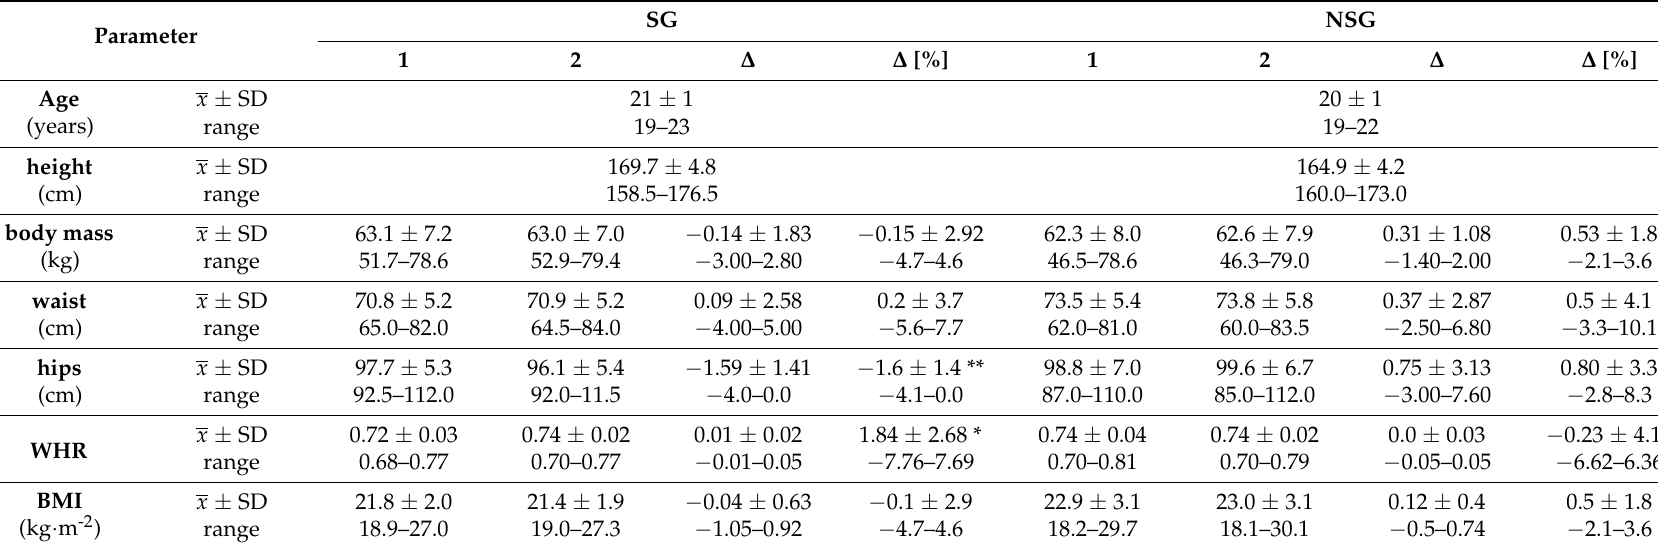
Table 1. Characteristic of the examined groups: SG (swimming group) and NSG (non-swimming group). Rest values pre (1) and post (2) 12-week swimming training. The values are given as mean ± SD. ∆ %—percentage